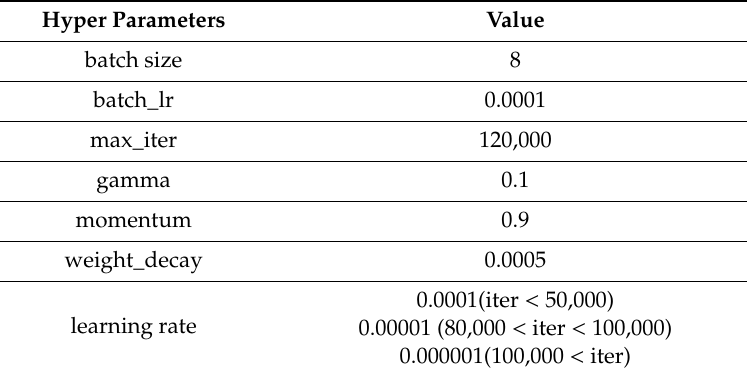
Table 2. Hyper parameters of MSF_SSD.